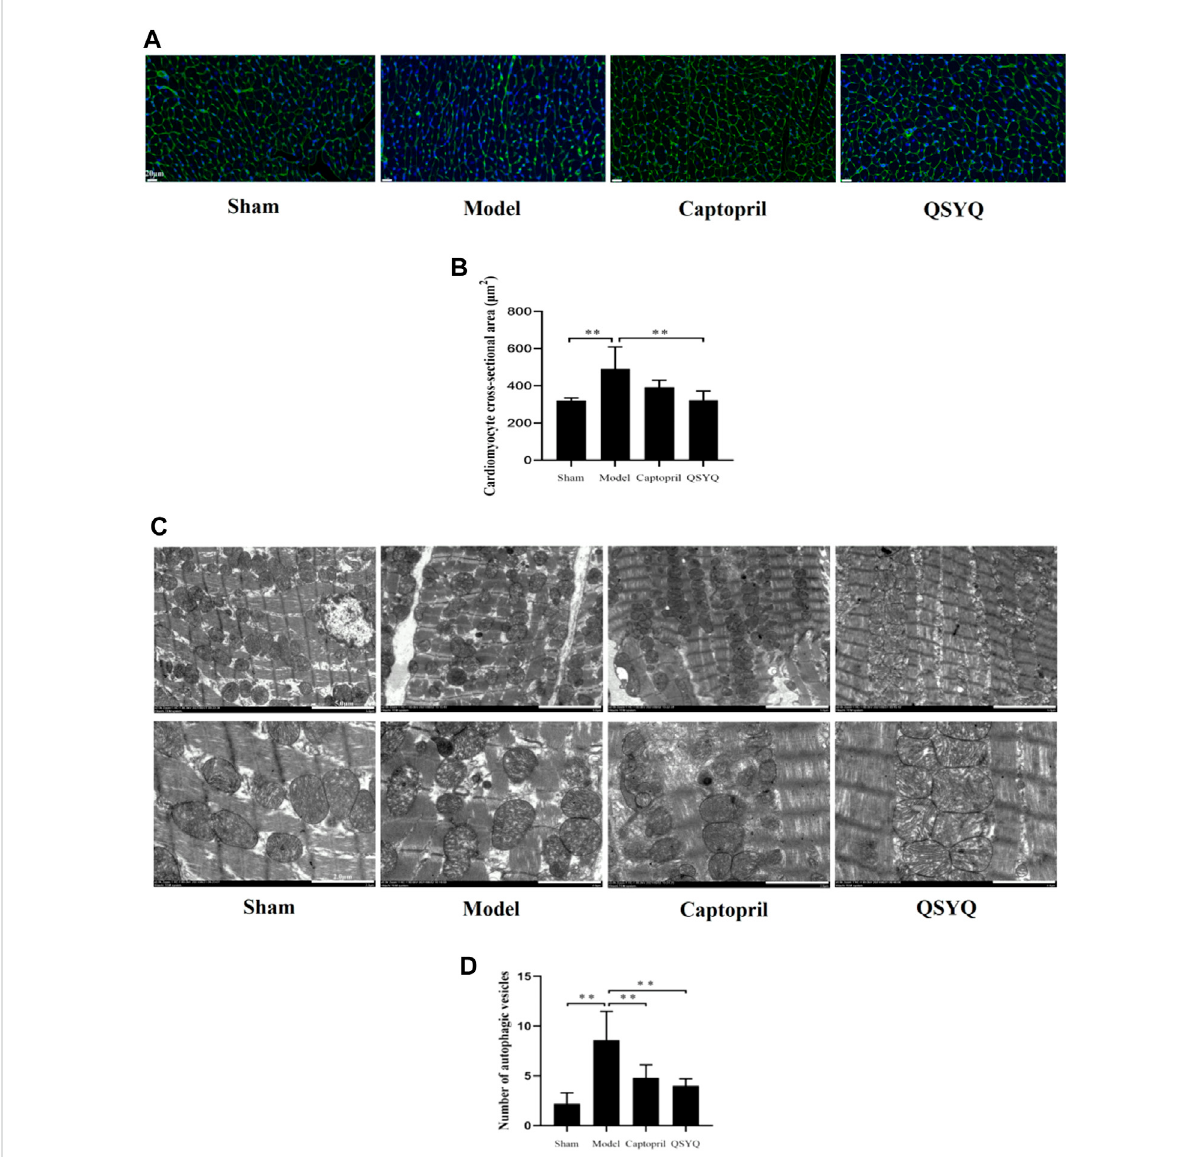
FIGURE 9 EffectofQSYQoncardiomyocytecross-sectionalareaandmyocardialautophagosomes. (A) :WGAstainingofmyocardialtissueshowedthatin model group the myocardial fi bers were disordered, the number of cardiomyocytes decreased, and the cross-sectional area of cardiomyocytes signi fi cantly increased.Comparedwiththemodelgroup,theoutlineofcardiomyocyteswasregular,andthecross-sectionalareaofcardiomyocytes wassigni fi cantlydecreasedinQSYQgroup. (B) :quantitativeanalysisofQSYQoncardiomyocytecross-sectionalarea, n =4pergroup.Dataare expressedasmean±SD.** p < 0.01. (C) :inmodelgroupthemyocardiumultrastructurewasdamaged.Themyocardialmembranewasdamaged,the myocardialcellappearededema,andthemyo fi lamentsweredissolvedandpartiallyruptured.Thenumberofautophagicvesiclesincreasedinmodel group. The ultrastructure of myocardium showed attenuated injury in both of the captopril and QSYQ groups. The number of autophagic vesicles decreased in both of the treatment groups. (D) : quantitative analysis of QSYQ on myocardial autophagosomes, n = 5 per group. Data are expressed as mean ± SD. ** p <